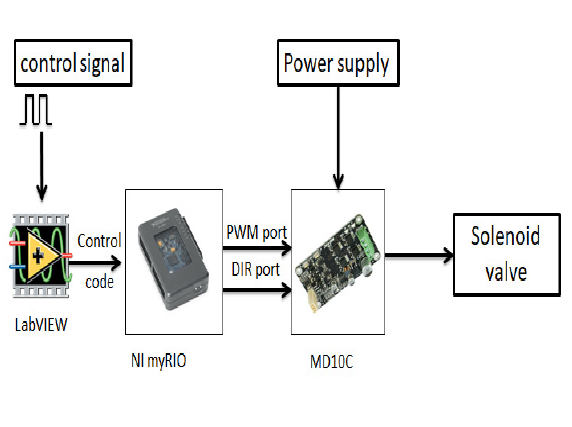
Figure 4. Hardware implementation of the proposed control method.